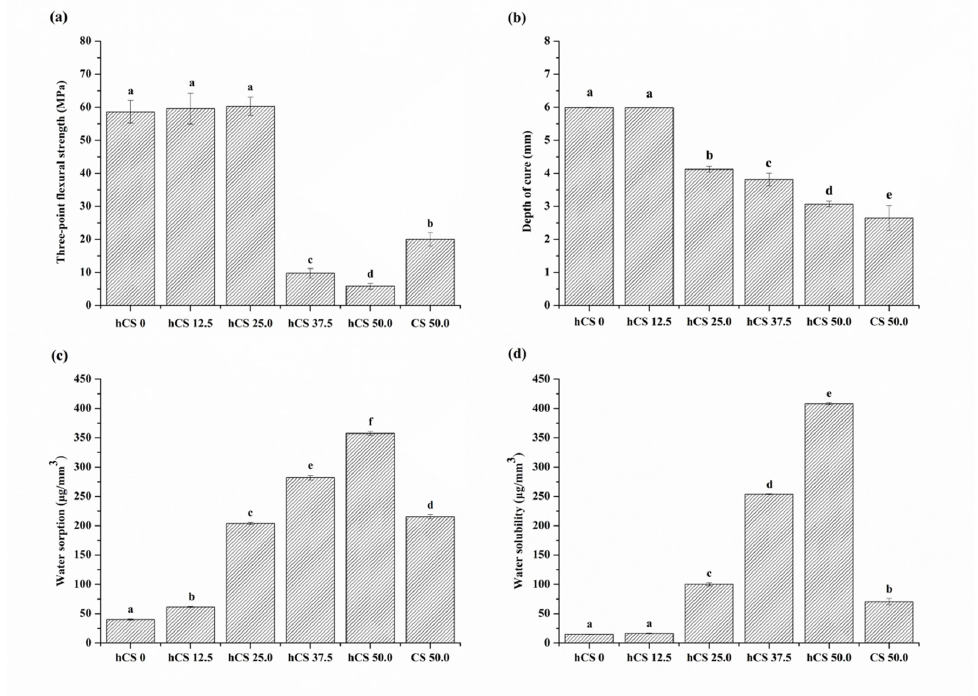
Figure 6. Results of the flexural strength ( a ), depth of cure ( b ), water sorption ( c ), and solubility ( d ) of each group. Each value represents the mean of 6 measurements, and the error bars represent the standard deviation of the mean (average ± standard deviation; n = 6). For each of the mechanical and physical properties, the same lowercase letter indicates no di ff erences among the experimental groups ( p > 0.05).